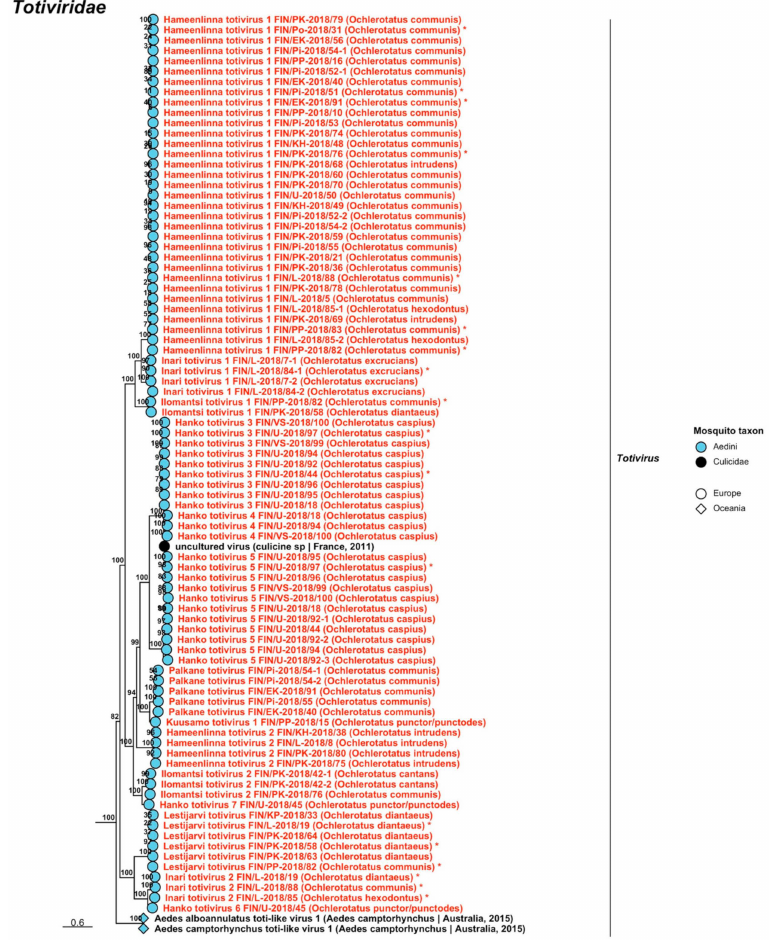
Figure 23. Maximum likelihood subtree of Totiviridae . Tentative novel viruses are displayed in red and the mosquito species from which they were derived are in parentheses. Sequences from GenBank are black and display the following information after the virus or species name: “(sampled organ- ism(s)|collection country, collection year)”. Tip colours represent the tribe of mosquito from which viruses were obtained. Tip shape represents the continent or region from which the specimens were collected. Trees were constructed from amino acid sequences of virus polymerases >1000 nt, aligned with MAFFT and computed with IQ-TREE2 using ModelFinder and 1000 bootstraps. Asterisks denote that the complete genome was